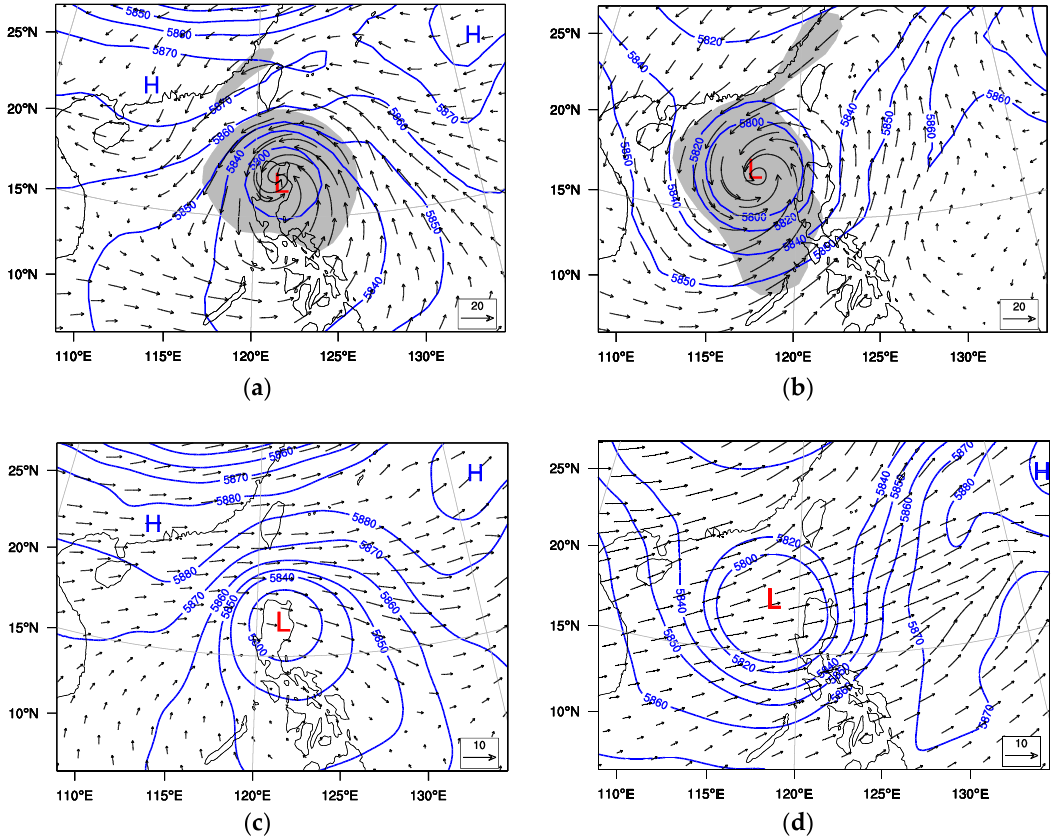
Figure 2. NCEP geopotential height at 500 hPa (unit: hPa), wind field at 850 hPa, areas where wind speed is more than 15 ms −1 (dashes) at ( a ) 0600 UTC 18 and ( b ) 0600 UTC 20; simulated geopotential height at 500 hPa (unit: hPa), wind field deviation between the simulation result and NCEP at 850 hPa at ( c ) 0600 UTC 18 and ( d ) 0600 UTC 20.